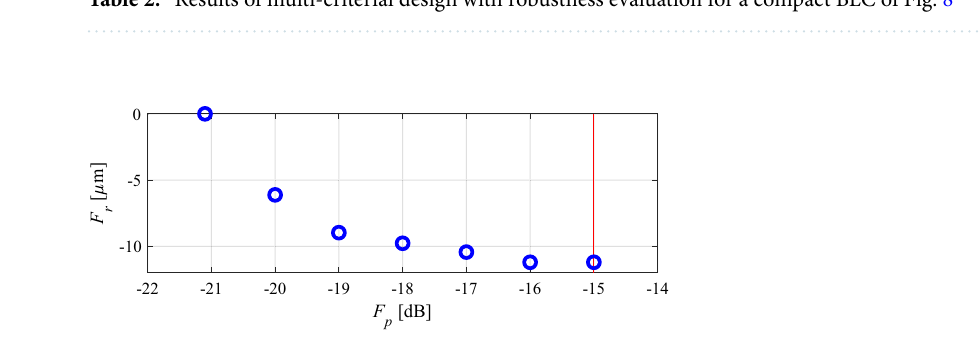
Figure 9. Compact BLC of Fig. 8: trade-off solutions generated using the introduced multi-criterial optimization framework. The maximal acceptable value of in-band | S 11 | and | S 41 | is marked using vertical